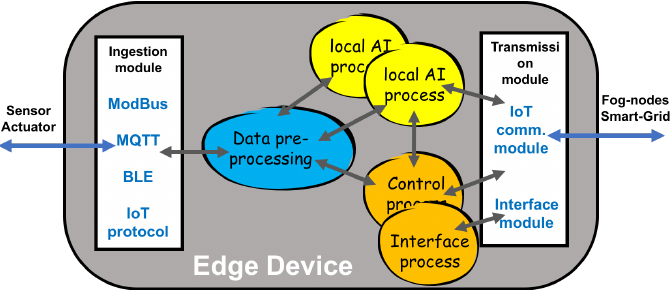
Figure 3. Relationship between the modules in an edge node according to the established